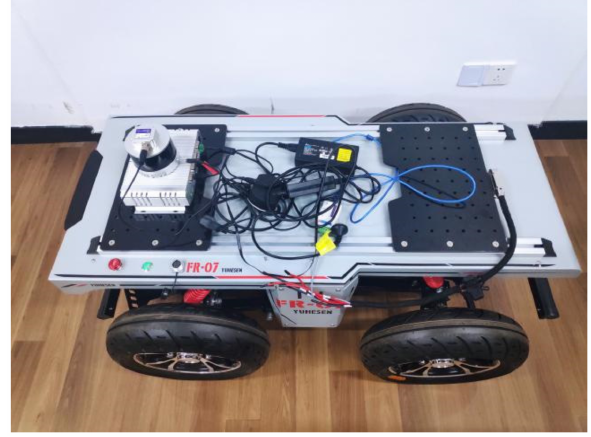
Figure 8. Experimental